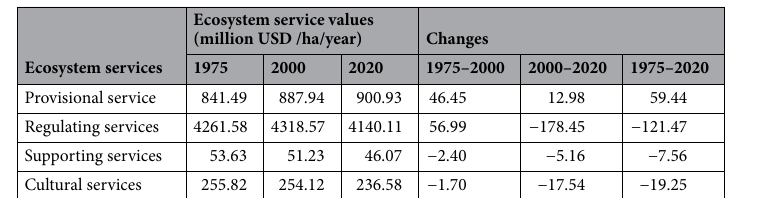
Table 5. ESVs of different services along with its change